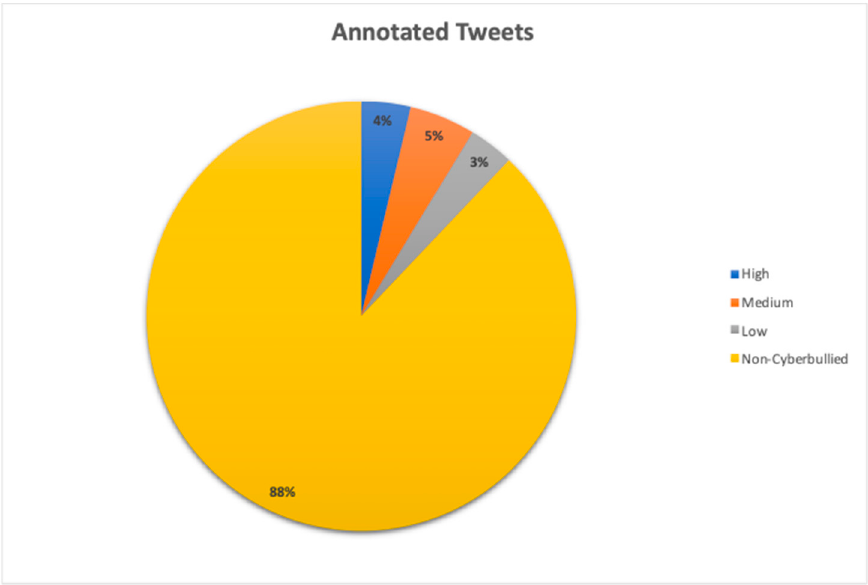
Figure 2. Annotated Dataset Distribution of Classes.